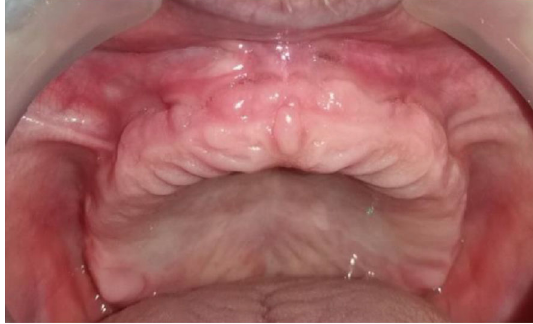
Figure 24: Intraoral view: right lateral frenulum.